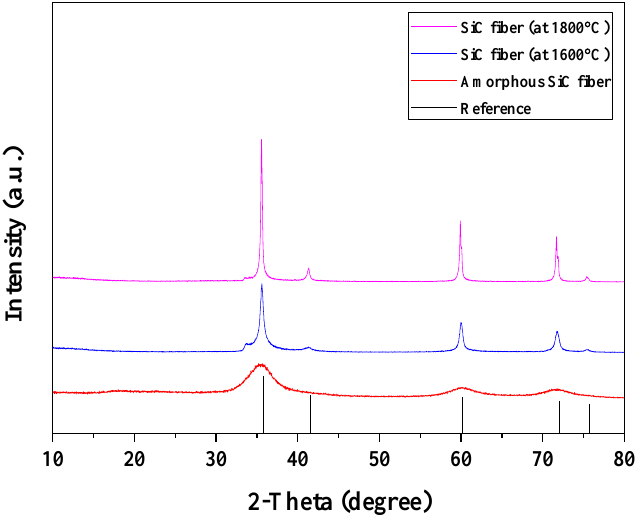
Figure 8. The schematic drawing of the crystallization behavior of polymer-derived SiC fibers.